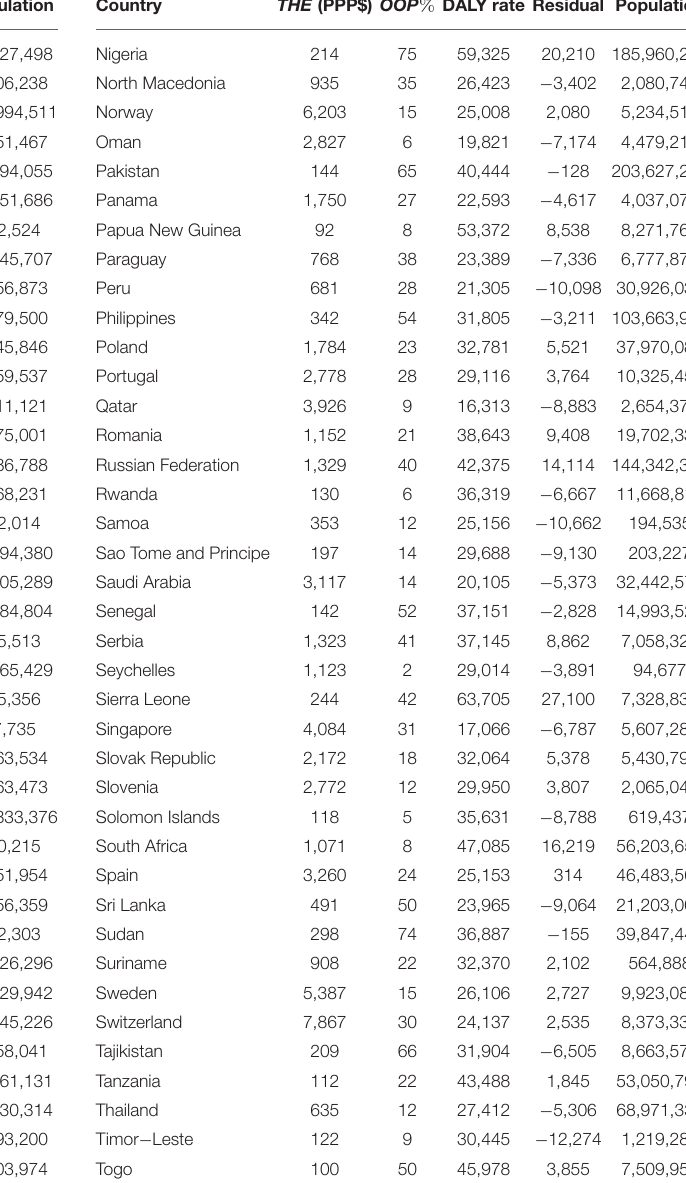
TABLE 13 | Estimated residuals for each country (Italy to Niger). Country THE (PPP$) OOP % DALY rate Residual Population